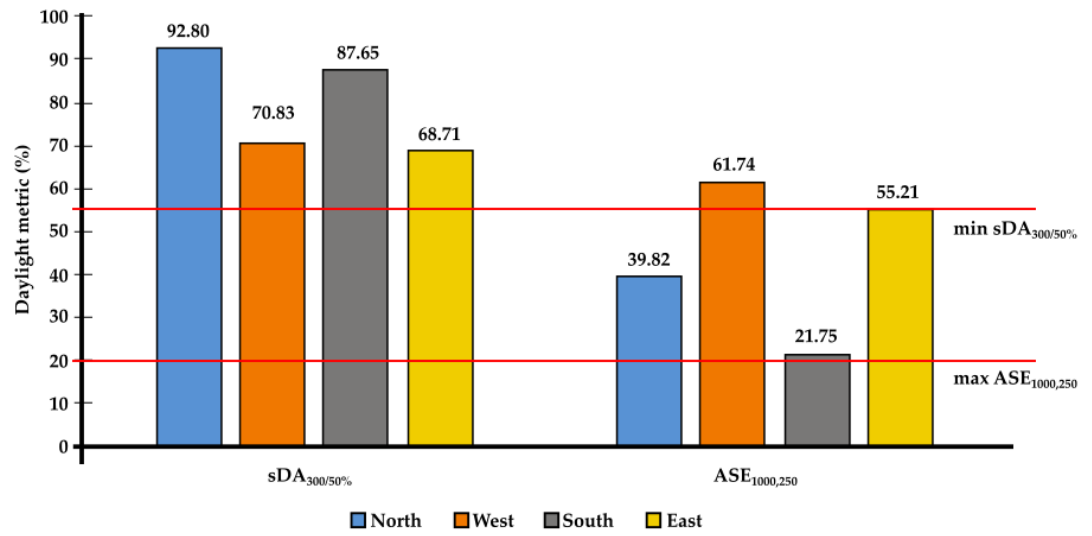
Figure 7. Annual simulation results in the baseline scenario.